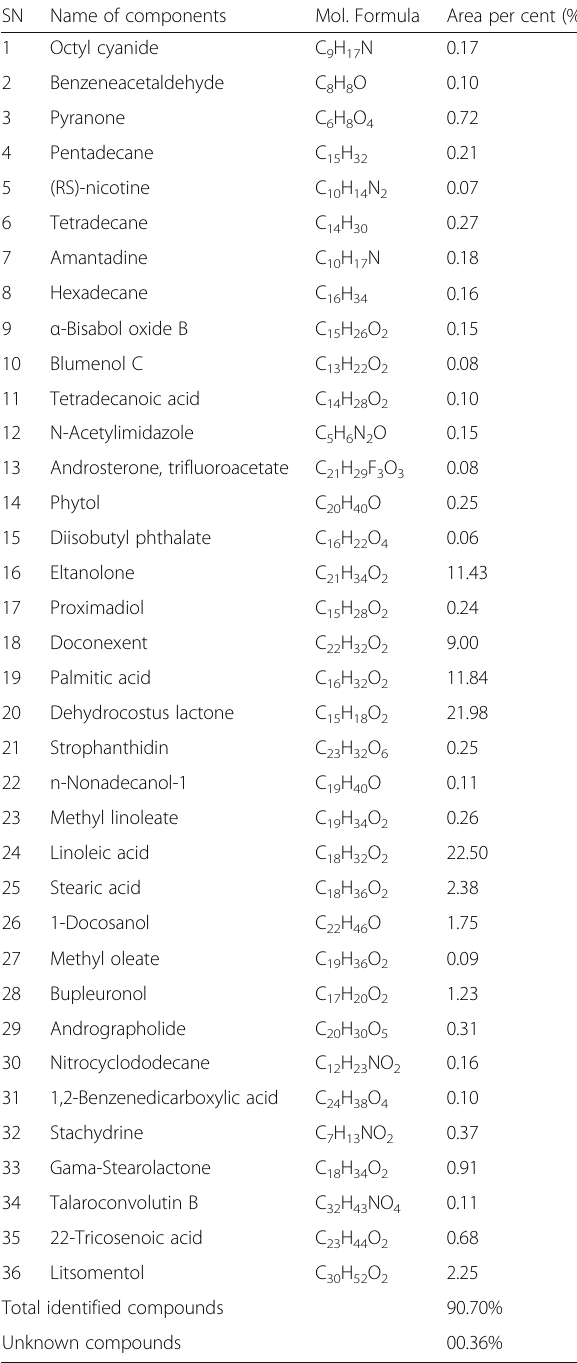
Table 3 Chemical composition of methanolic leaf extract of Saussurea